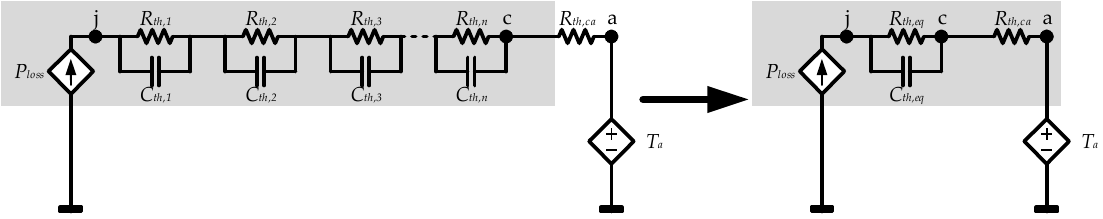
× n RCs to 12 × 1 RCs.